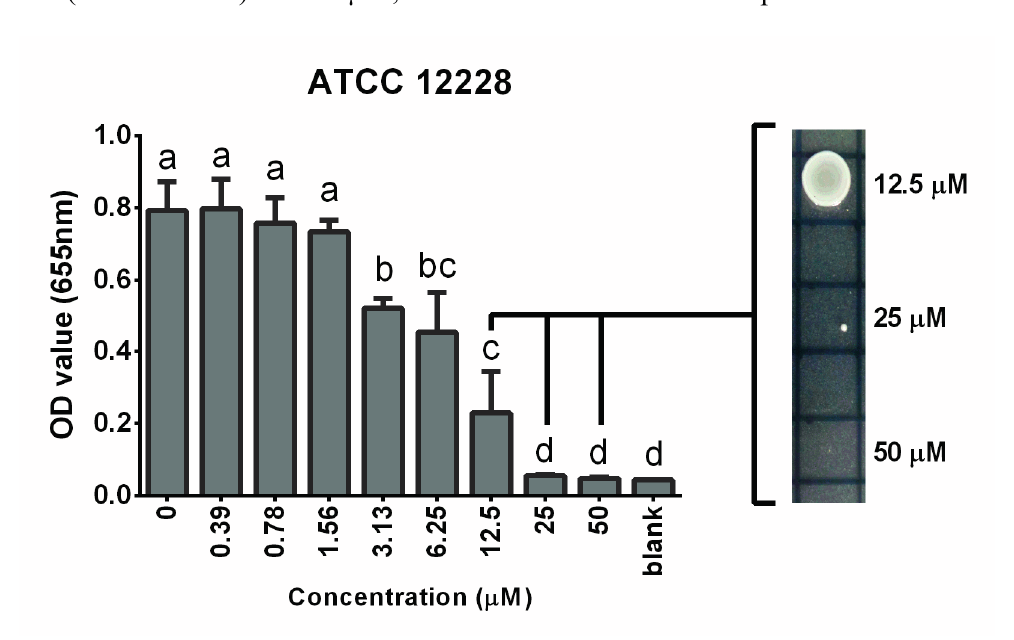
Figure 1. Mean (±SEM) OD values of S. epidermidis (ATCC 12228) after exposure to cadmium (0.39–50 µM); measured at 655 nm wavelength. Different letters (a–d) indicate significant difference between compared groups. 12.5, 25, and 50 µM cadmium treatment groups were chosen for drop plating (right side